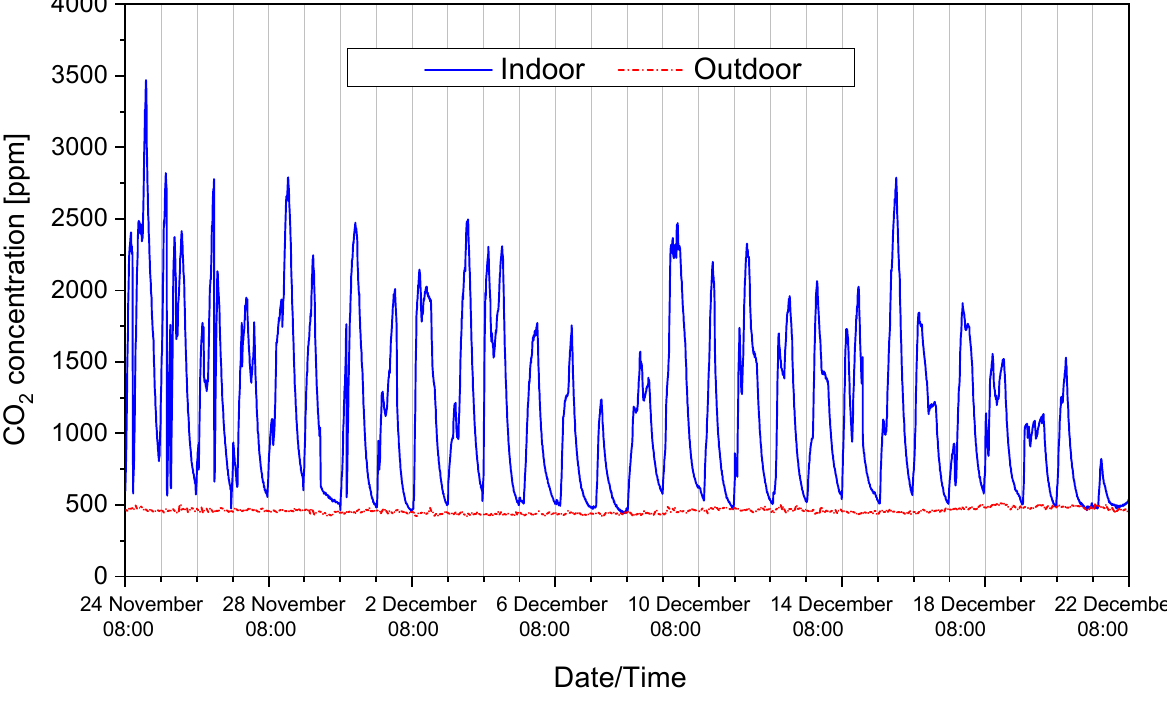
Figure 6. Indoor and outdoor CO 2 concentration during monitoring period. According to ASHRAE Standard 62.1 [18] and the Chinese indoor air quality standard GB/T 18883 [19], indoor CO 2 concentration should be kept below the commonly referenced guideline of 1000 ppm (8–h average). However, based on the measured data, there was a large chunk of time when indoor CO 2 concentration exceeded the guideline each day. Figure 7 shows the cumulative frequency of indoor CO 2 concentration during the measur- ing period. Over 50% of the measured data were more than 1000 ppm. A total of 27.8% of the measured data were more than 1500 ppm and 1.7% of the measured data exceeded 2500